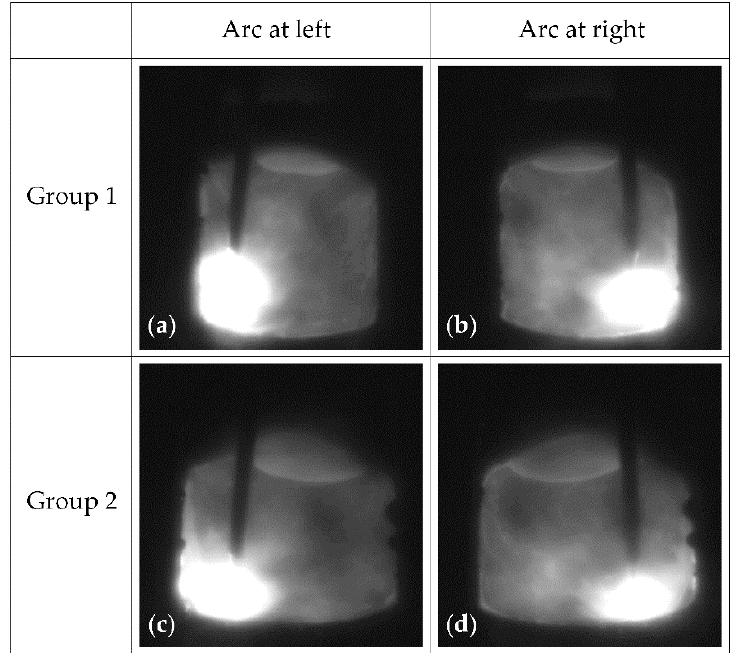
Figure 11. Actual welding images at groove lengths of around 29 mm and 179 mm: ( a ) welding image while arc stays at left at groove length of ~29 mm; ( b ) welding image while arc stays at right at groove length of ~29 mm; ( c ) welding image while arc stays at left at groove length of ~179 mm; ( d ) welding image while arc stays at right at groove length of ~179 mm.